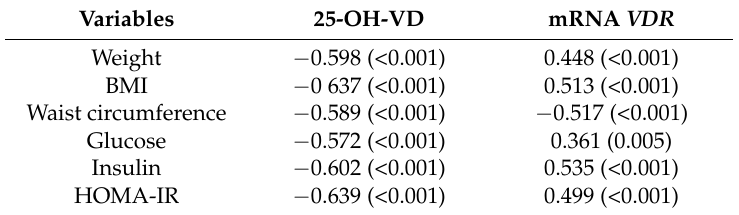
Table 2. Spearman correlations between serum level of 25-OH-VD and expression of VDR with anthropometric and biochemical parameters in all the patients (control, LIR-MO, and HIR-MO patients).